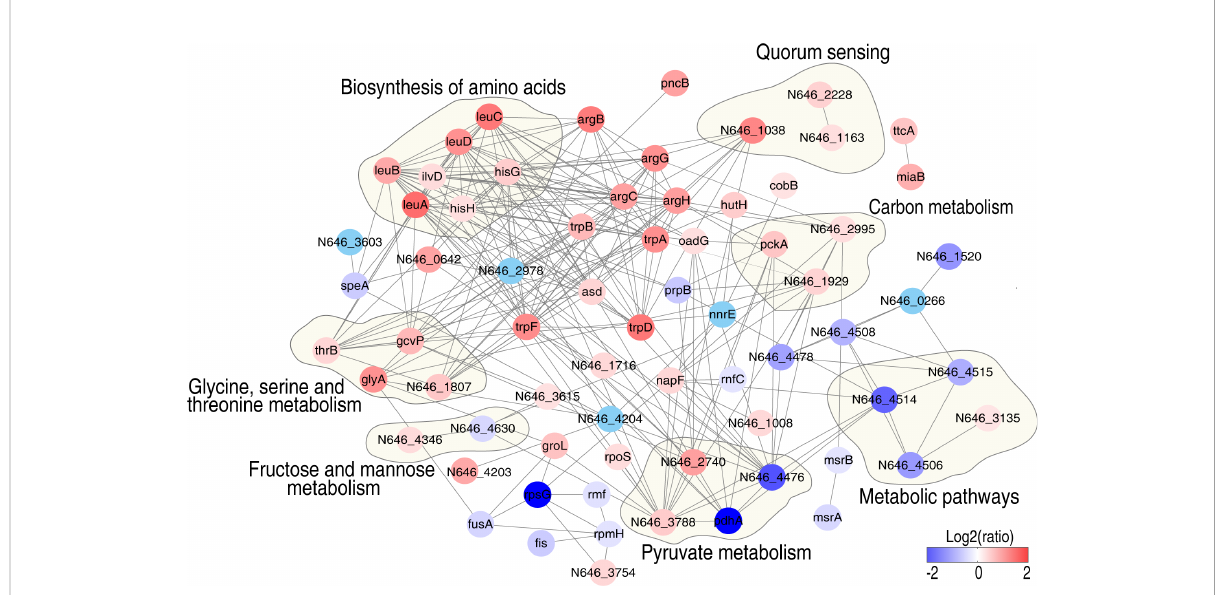
FIGURE 4 Interaction of differentially expressed proteins in the presence of glycine in V. alginolyticus . Protein – protein interaction prediction using STRING software. The circles indicate the enriched Kyoto Encyclopedia of Genes and Genomes pathways. Differently colored dots indicate the altered proteins, blue dots represent downregulated proteins, and red dots represent upregulated proteins, respectively (see the color